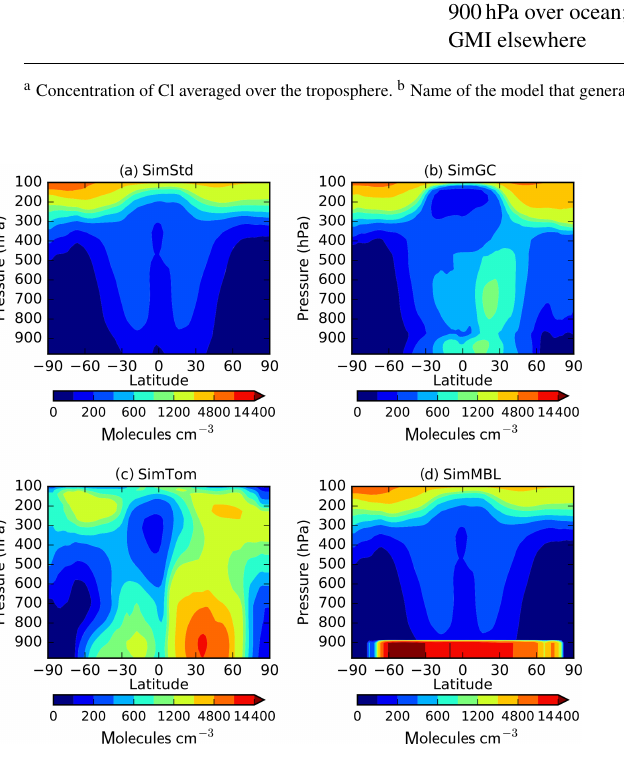
Figure 2. Annual zonal mean Cl field for (a) SimStd, (b) SimGC, (c) SimTom, and (d) SimMBL.